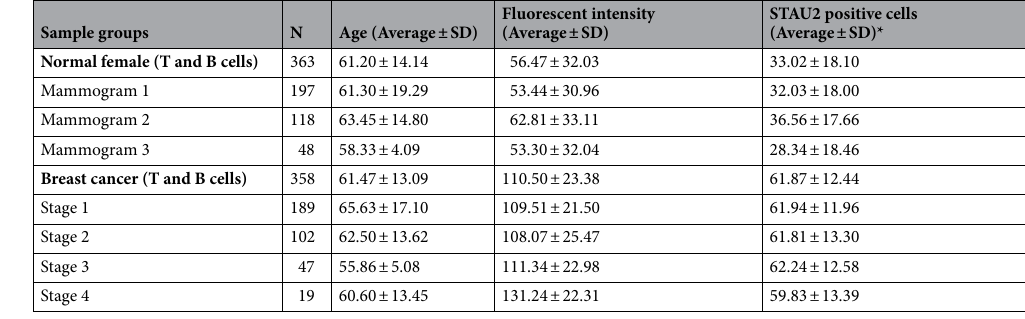
Table 1. The demographic data of all samples in this study included normal female WBCs (N = 363) from mammograms 1 to 3 and breast cancer WBCs (N = 358) from stage 1 to 4 disease. The average fluorescence intensity and the percentage of STAU2-positive cells are presented as the average ± SD. Abbreviation: STAU2, staufen-2. *Data are presented as